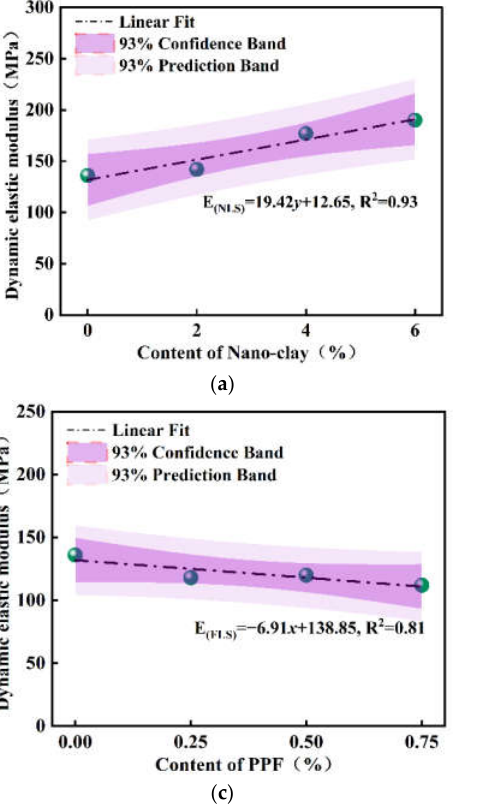
Figure 10. Dynamic elastic modulus: ( a ) dynamic elastic modulus curve of NLS; ( b ) dynamic elastic modulus curve of NFLS (N = 6%); ( c ) dynamic elastic modulus curve of FLS; ( d ) dynamic elastic modulus curve of NFLS (F = 0.75%).